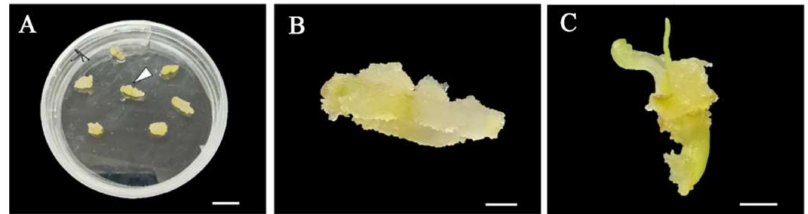
Figure 2. Callus and adventitious buds from root tips of A. praecox induced by the combination of hormones PIC, NAA and KT for 20 days. ( A ) The yellowish callus. Bars = 1 cm; ( B ) callus collected, respectively, from the explants indicated by arrows in A . Bars = 0.2 cm; ( C ) Adventitious bud. Bars = 0.2